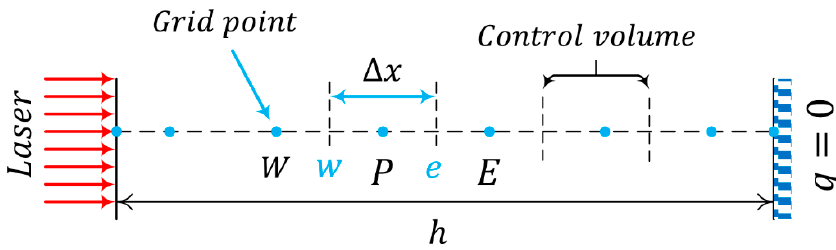
Figure 1. A schematic view of the physical model.